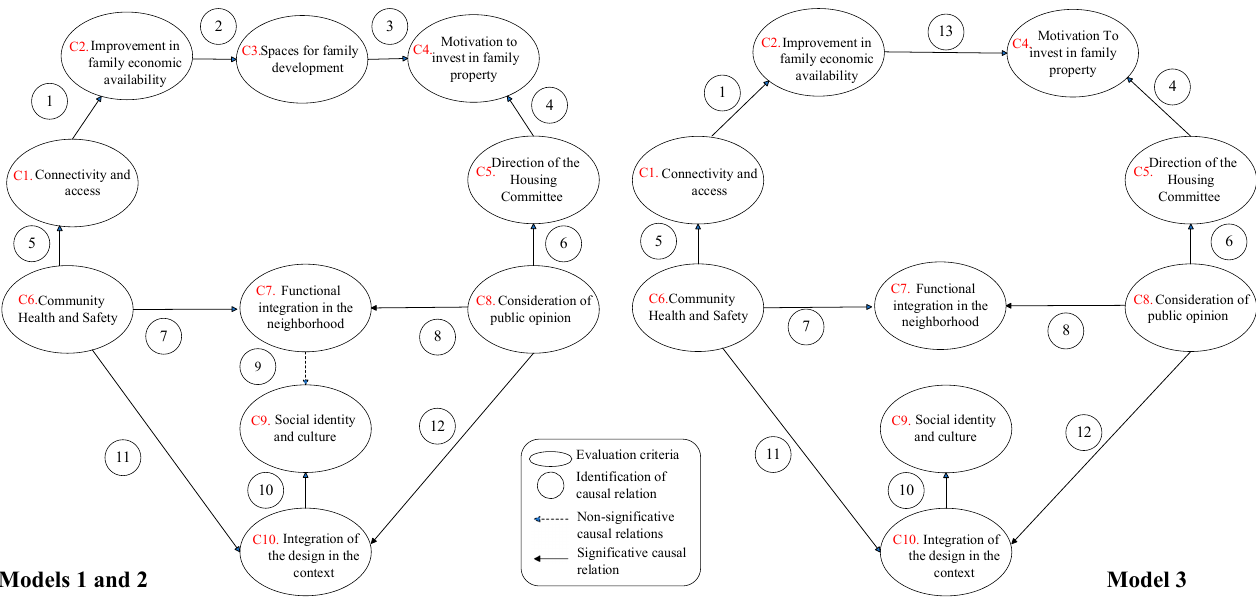
Figure 2. Structures of the evaluated model 1, 2 and 3. The model is estimated using maximum likelihood. The reason why we use a method that depends on some distributional requirements is that the literature indicates bootstrap can only be applied when a large sample size is available [91,92], which is not the case in this study. However, as Arbuckle [92] indicates, the multivariate normality of observed variables is a standard distribution assumption in structural equation modeling. The goodness-of-fit statistics in the three models of Figure 2 were similar, indicating that the RMSEA and the Parsimony-Adjusted Measures Index (PNFI) fulfilled the usual